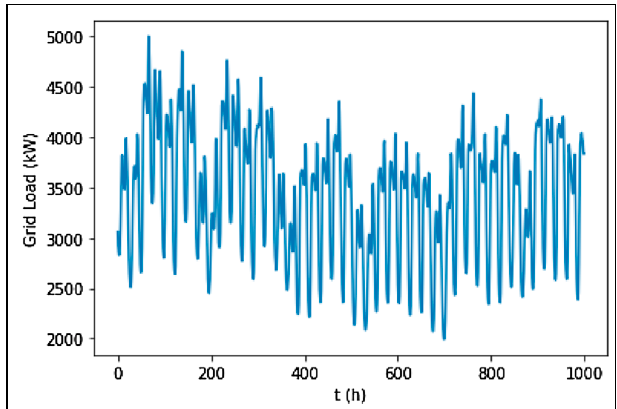
FIGURE 5 | Example of load in the training dataset in 1,000